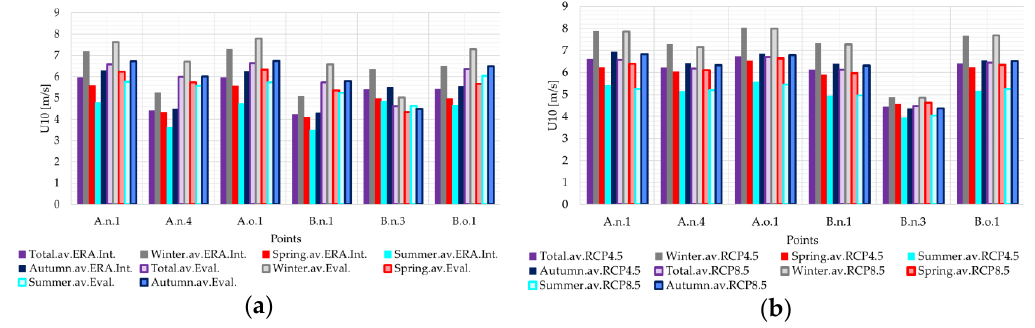
Figure 6. Annual averages of the wind speed at 10 m height for two of the most representative points located in shallow water (C.n.1) and in deep water (C.o.1) of Turkey. ERA.Int and Eval data, time